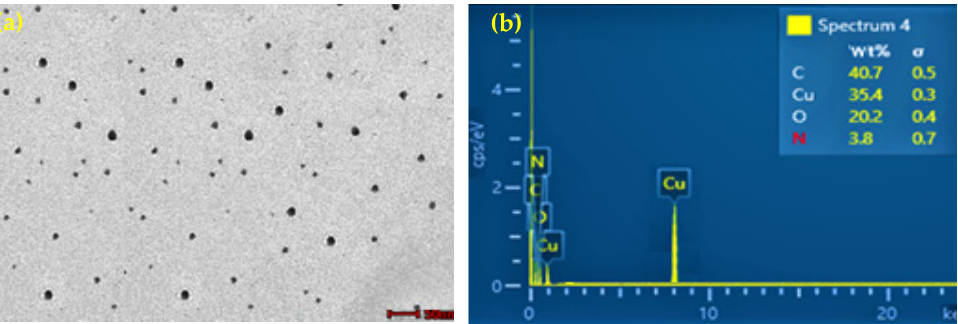
Figure 4. ( a ) TEM micrograph and ( b ) energy-dispersive X-ray (EDX) spectra of poly(hydroxamic acid)-Cu(II) complex.